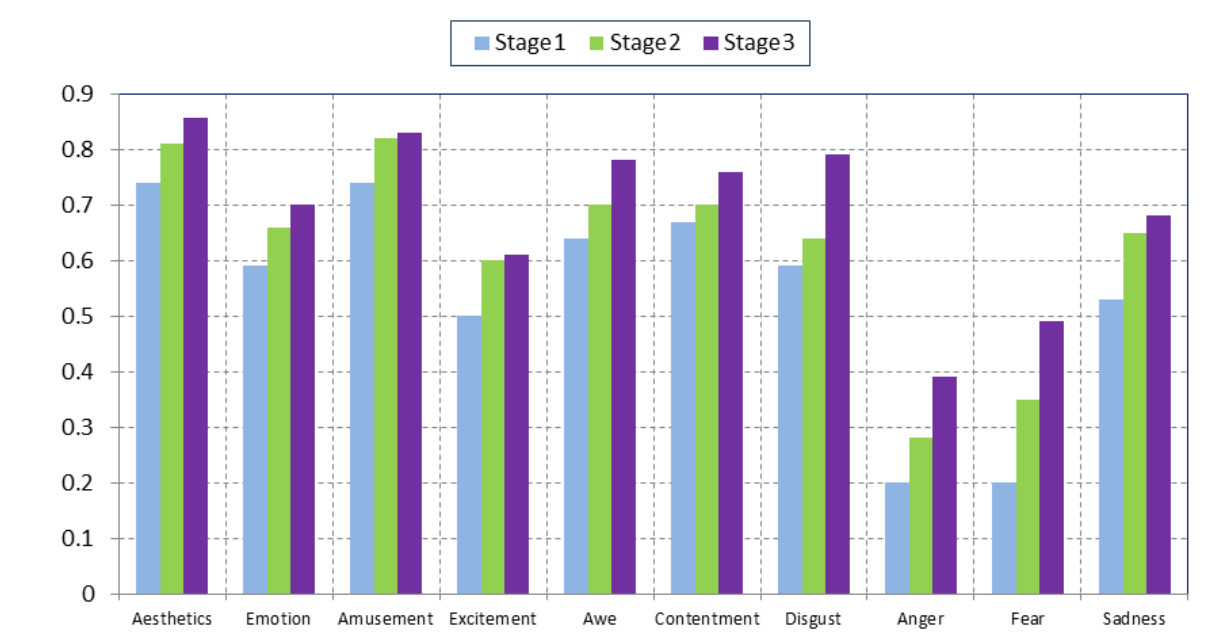
Figure 9. Results in different stages on IAE. Table 3. Comparison of the model without or with different GCN on IAE for aesthetics assessment and emotion recognition, respectively (aesthetics is abbreviated as Aes, emotion as Emo, and accuracy as